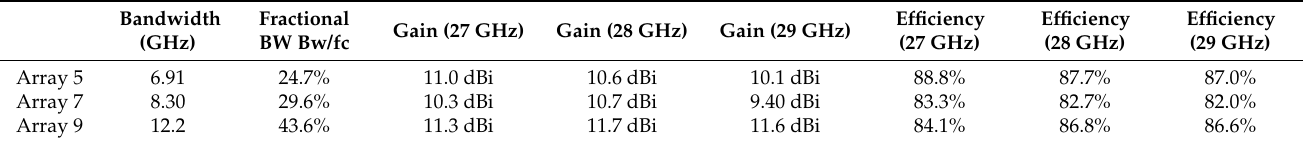
Table 3. Comparison between the main results from the three designed arrays.